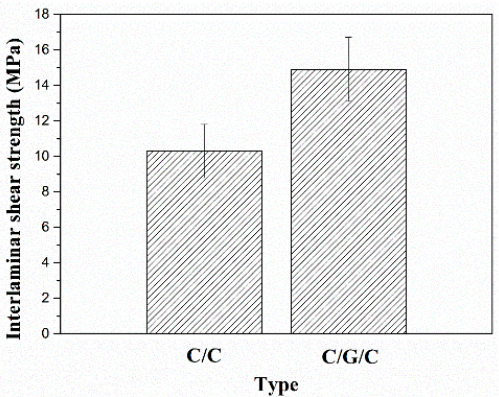
Figure 10. Interlaminar shear strength of the C/C and C/G/C composites.